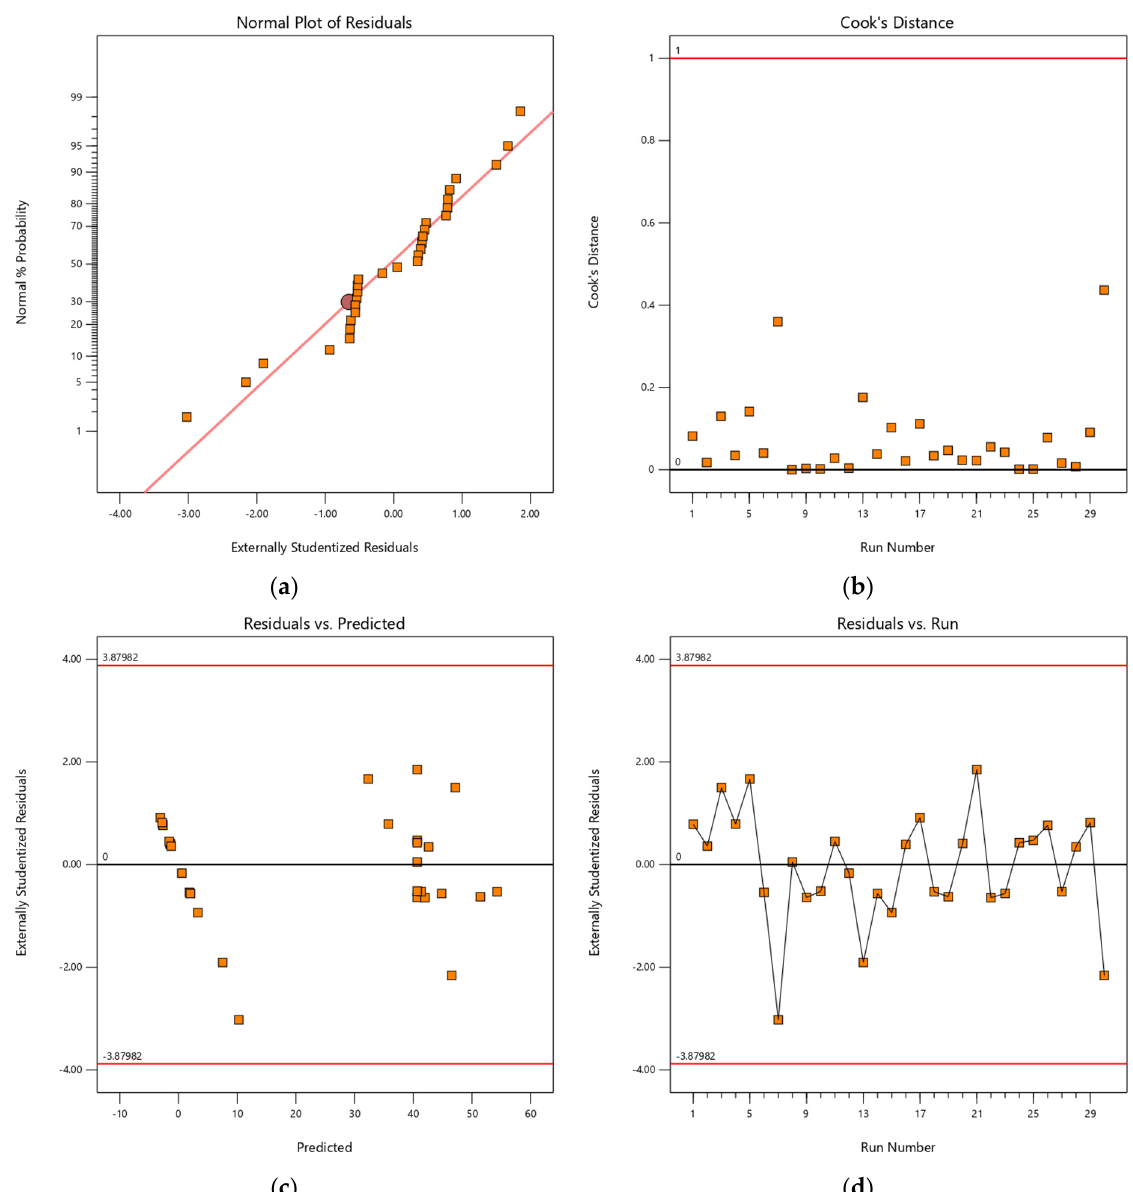
Figure 12. ( a ) A normal plot of residuals, ( b ) Cook’s distance, ( c ) residual vs. predicted and ( d ) residual vs. run plots for Cu(II) loaded onto H + Dowex-M4195 chelating resin from a selected quadratic model term.